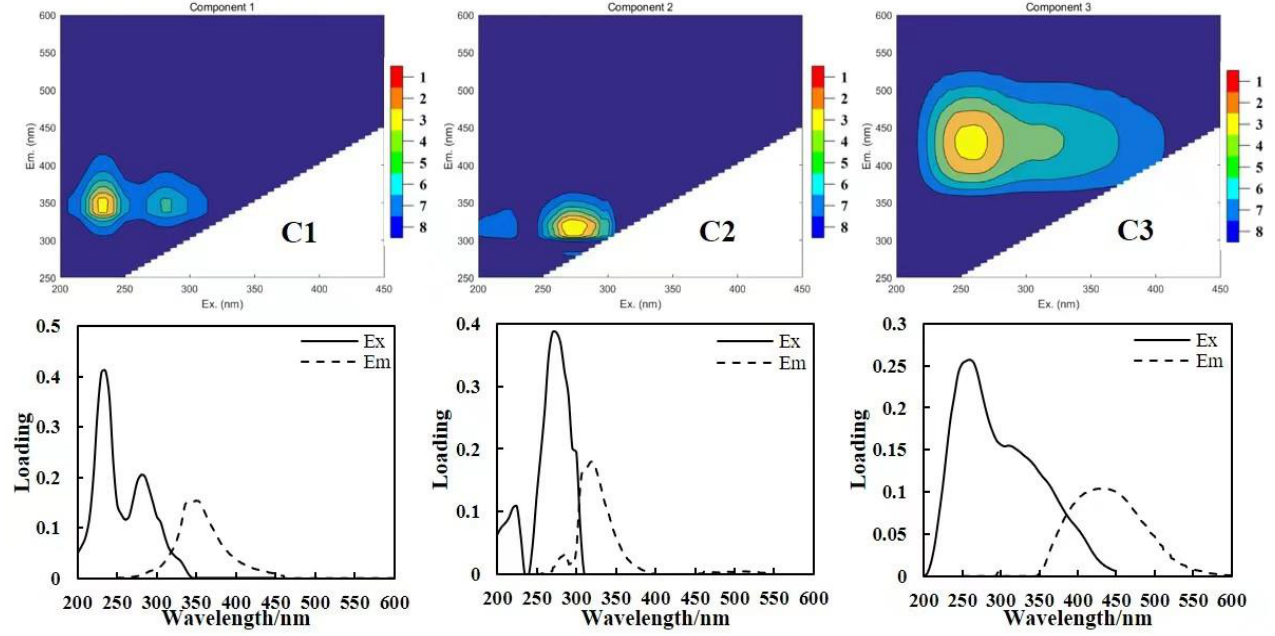
Figure 5. Excitation emission fluorescence spectra obtained by PARAFAC.